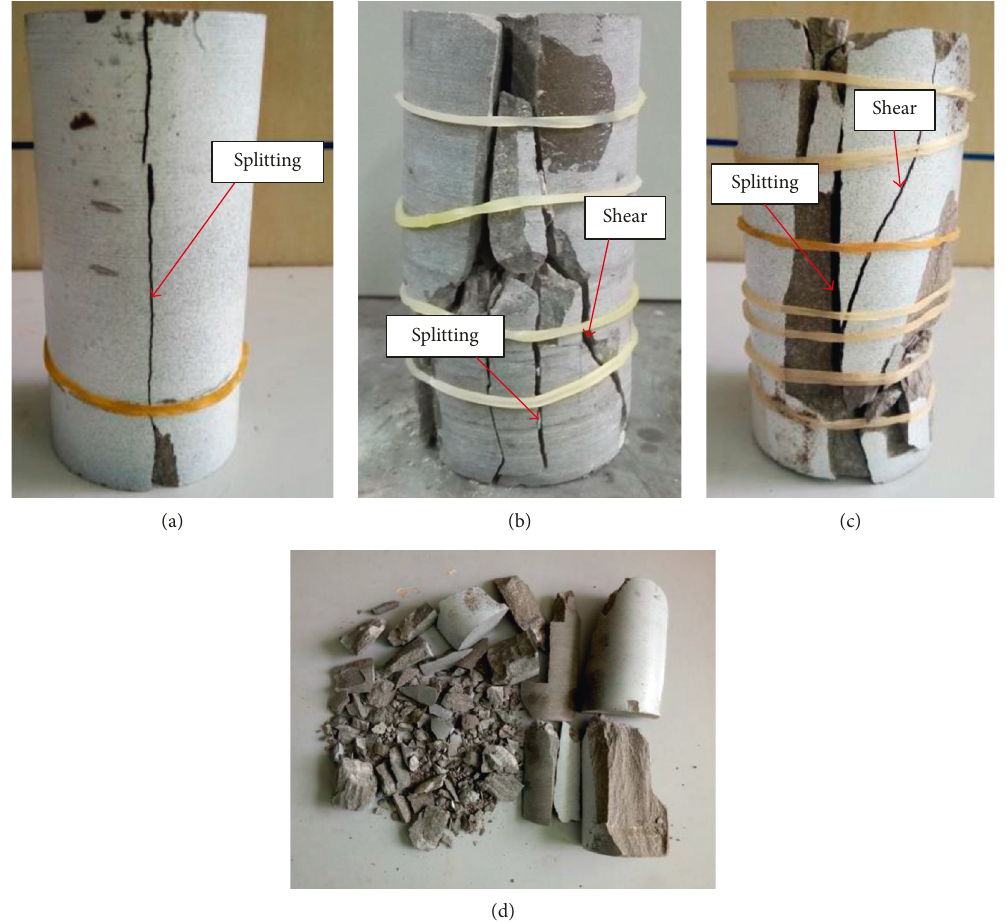
0.03mm/min), (b) #4 (loading rate (cid:31) (cid:31)